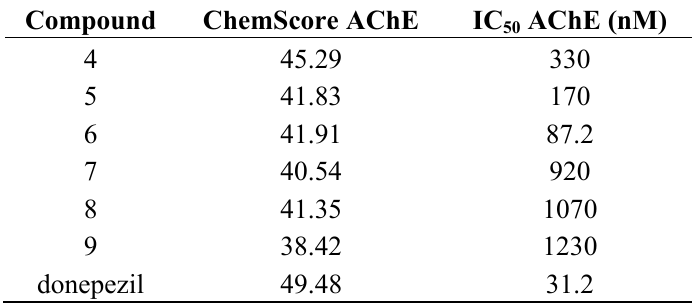
Table 4. Assessment of the investigated compounds as potential AChE